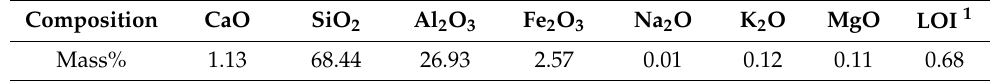
Table 1. Chemical composition of K